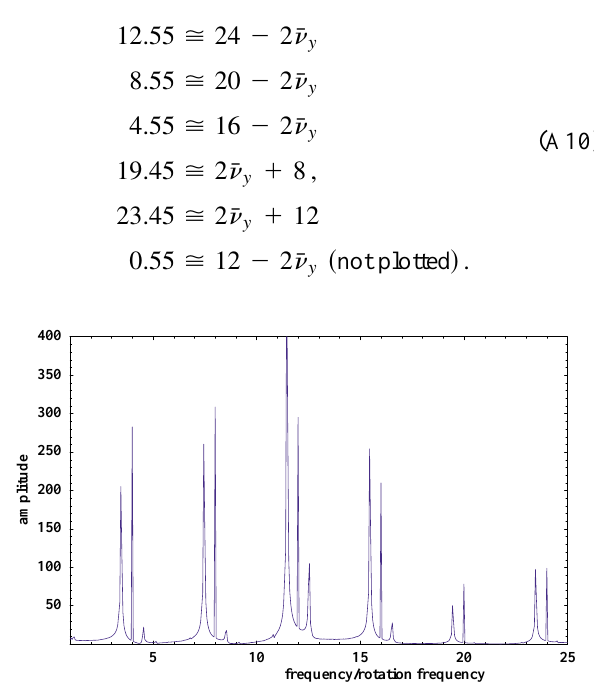
FIG. 24. (Color) Spectrum of (cid:5) y 2 (cid:6) after 250 turns (working point 5.82, 5.77